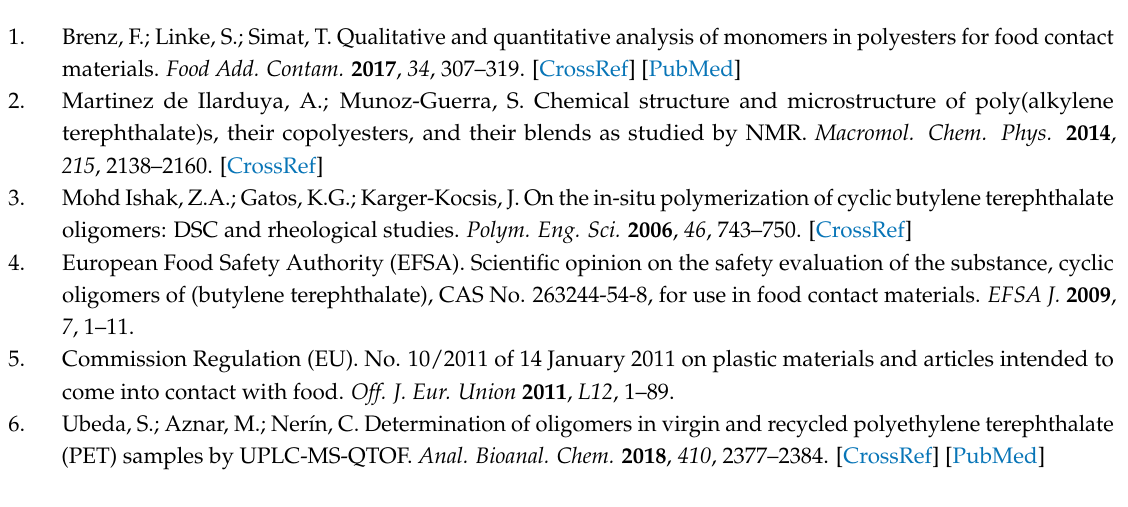
Figure S1. 1 H-NMR spectrum of FCM 885 and 4 PBT cyclic dimer, trimer, tetramer & pentamer; (a) Mixture, (b) PBT dimer, (c) PBT trimer, (d) PBT tetramer, (e) PBT pentamer. Figure S2. 13C-NMR spectrum of FCM 885 and 4 PBT cyclic dimer, trimer, tetramer & pentamer; (a) Mixture, (b) PBT dimer, (c) PBT trimer, (d) PBT tetramer, (e) PBT pentamer. Figure S3. Monodimensional 13 C-NMR and 1 H-NMR of PBT cyclic dimer. Figure S4. qNMR spectra of the isolated PBT cyclic dimer, using dimethyl sulfone as internal standard. Figure S5. Cause-effect diagram of uncertainty contributions. Table S1. Purity and expanded uncertainty assessment for the isolated PBT oligomers by